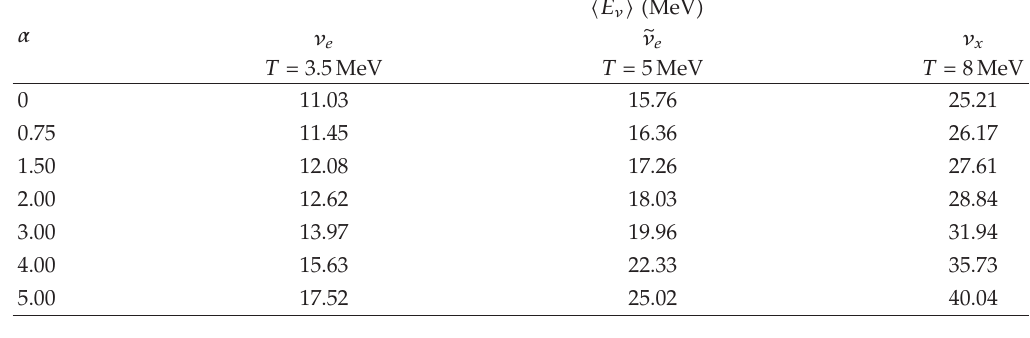
Table 1: The average supernova neutrino energies as a function of the parameters α and T .